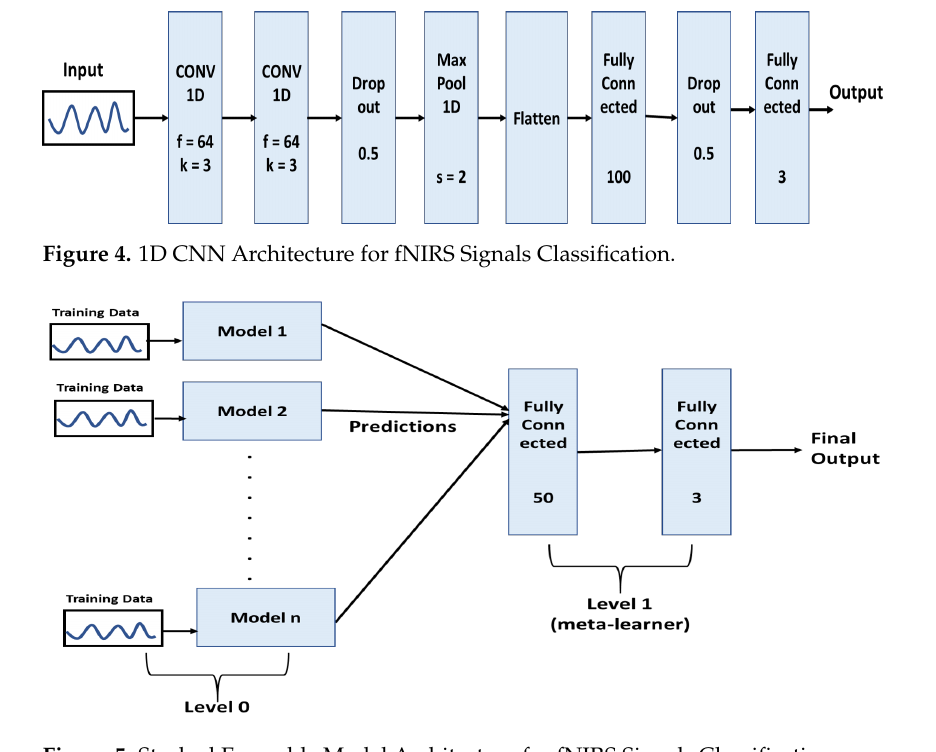
Figure 5. Stacked Ensemble Model Architecture for fNIRS Signals